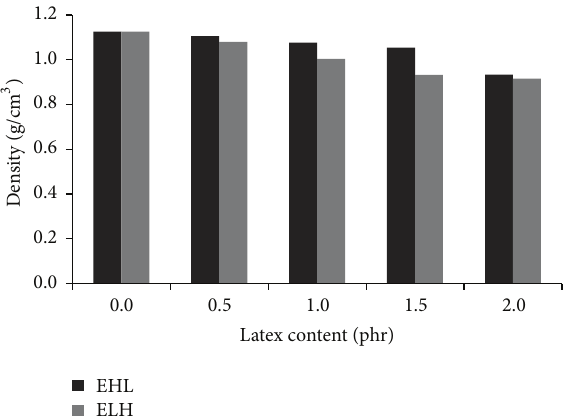
Figure 2: Density of porous epoxy extracted by toluene using mixing sequence of EHL and ELH,